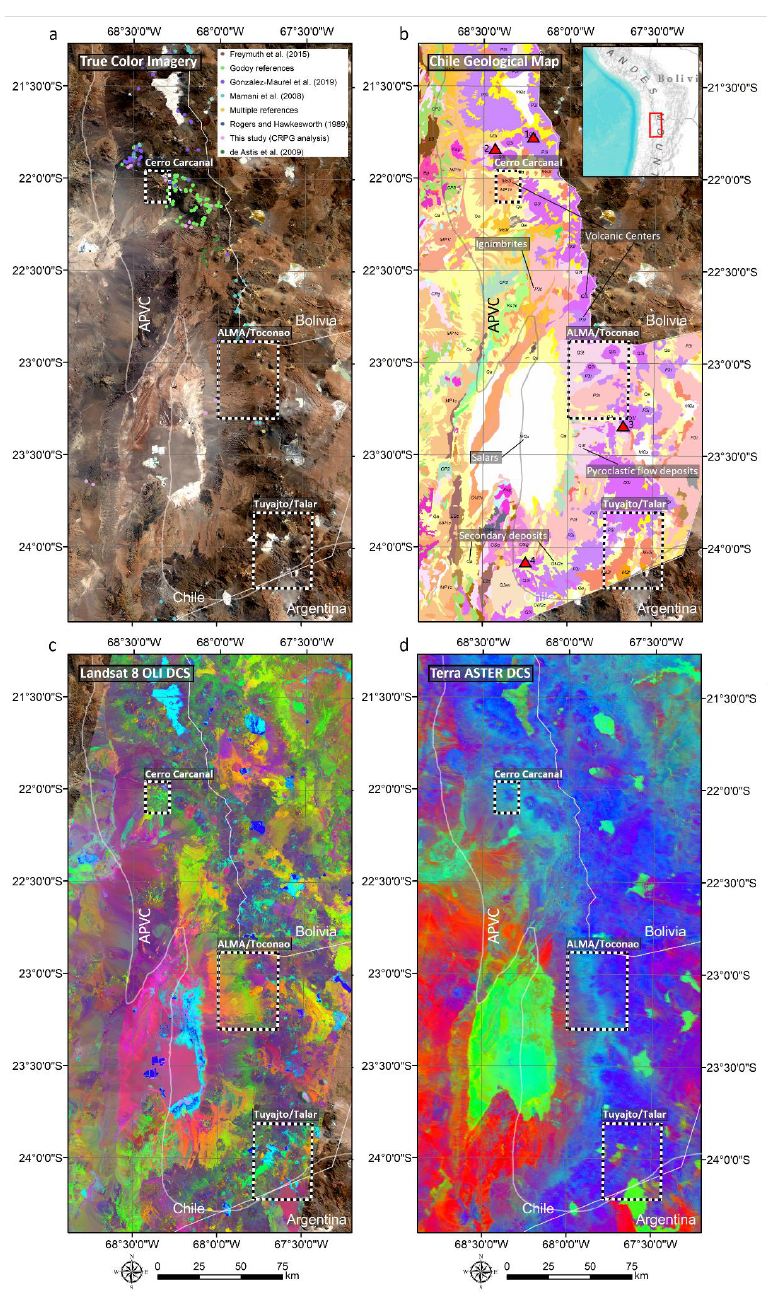
Figure A1. ( a ) Landsat 8 OLI radiance true color imagery of the APVC. Sampling locations used for comparison to ASTER silica content map are shown and grouped by source reference. The group “Godoy references” includes Godoy [90] and Godoy et al. [28,71,91]. The group “Multiple references” includes Francis et al. [92], Freymuth et al. [93], Mamani et al. [94], and Rogers and Hawkesworth [95]. ( b ) Geological map of Chile from Servicio Nacional de Geolog í a y Miner í a [69]. Some geological units and features mentioned in the main text are indicated. Red triangles indicate volcanoes: 1 Azufre and Chanka, 2 San Pedro-San Pablo and La Poruña, 3 Lascar, 4 El Negrillar. Full descriptions of the geological units are extensive, and the reader is referred to [69]. ( c ) Landsat 8 OLI reflectance DCS using bands 7, 6, and 4 as red, green, and blue, respectively. ( d ) ASTER DCS using bands 14, 12, and 10 as red, green, and blue, respectively. On all four maps, three regions selected in this study are indicated by rectangles, and the approximate APVC boundary is